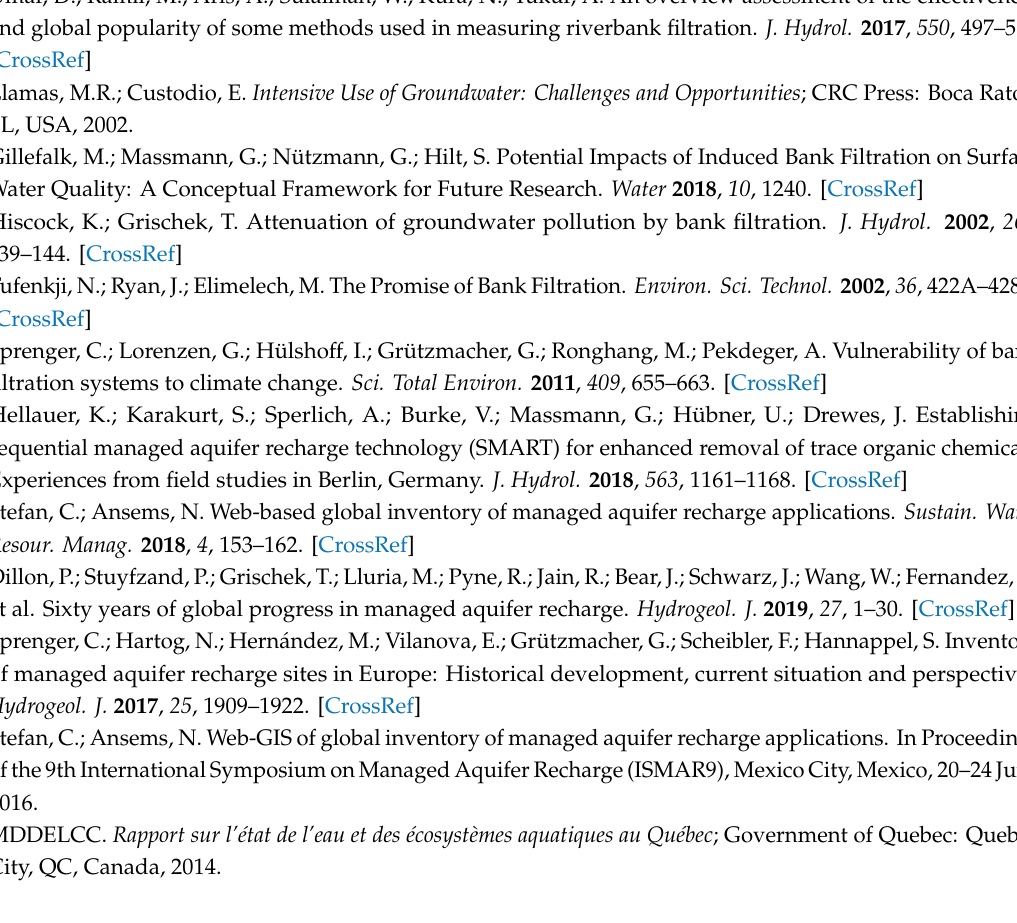
Figure S1: Map of Areas #1 (Laurentides) with quaternary geology and well distribution, Figure S2: Map of Areas #2 (Nicolet) with quaternary geology and well distribution, Figure S3: Map of Areas #3 (Vaudreuil